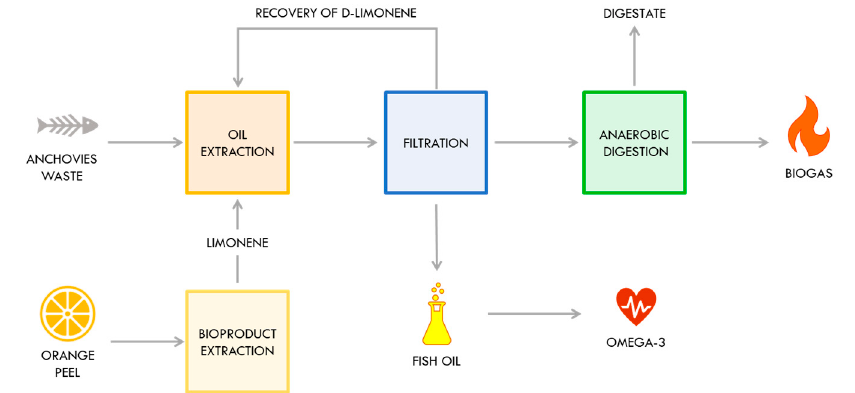
Figure 1. Biorefinery scheme for the full valorisation of anchovy waste.